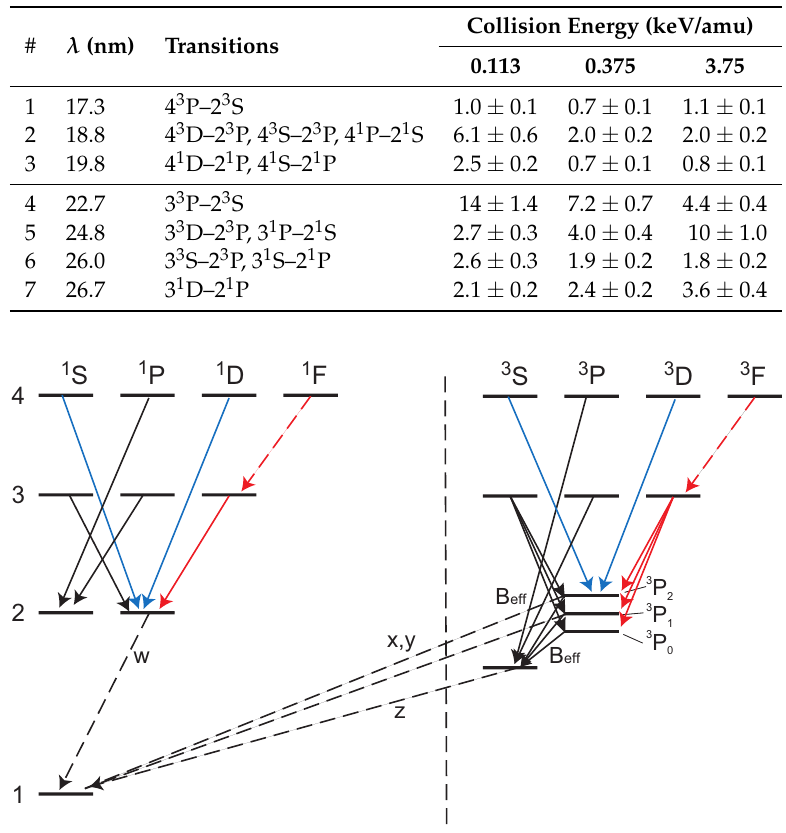
Figure 1. Part of the decay scheme of the Grotrian diagram of C V . Lines detected by our experiment are indicated by solid lines; other lines that were not observed but that are relevant to this work are indicated by dashed lines. Red indicates the transitions used for the TS 3 triplet-to-singlet ratio; Blue indicates the transitions used for the TS 4